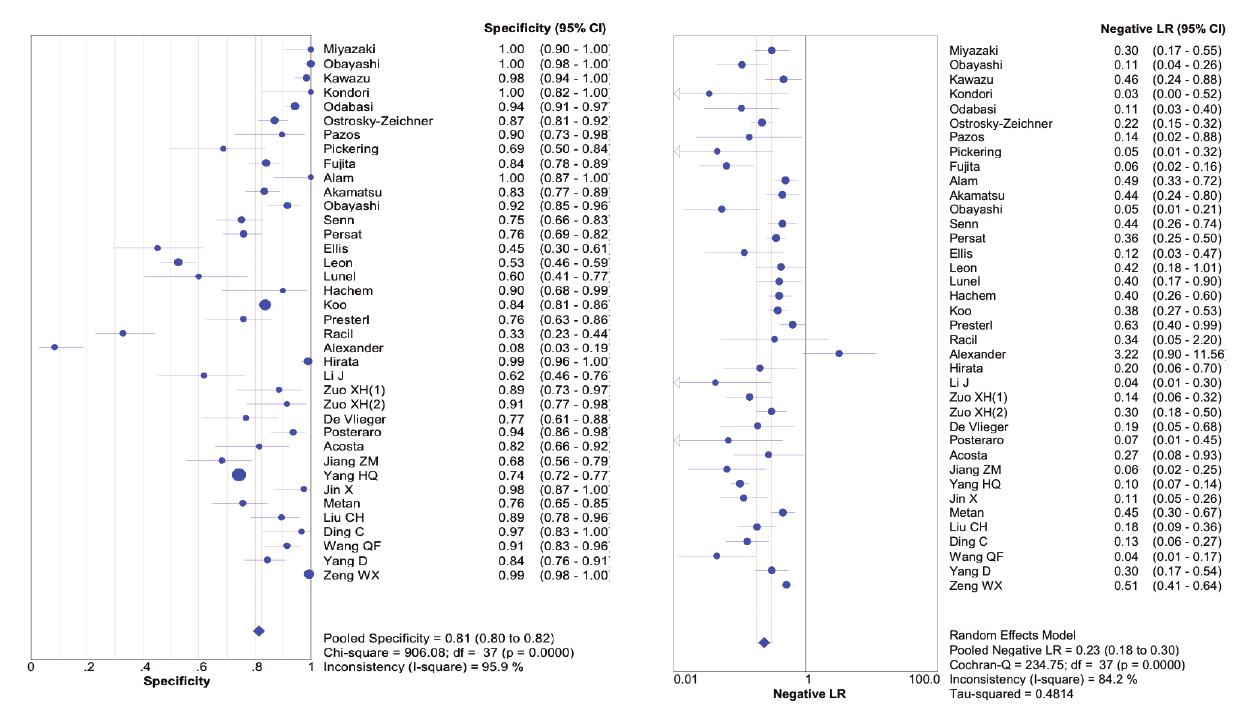
Figure 4: Pooled forest plot of specificity of 1,3-β-D-glucan in diag- nosis of invasive fungal infection